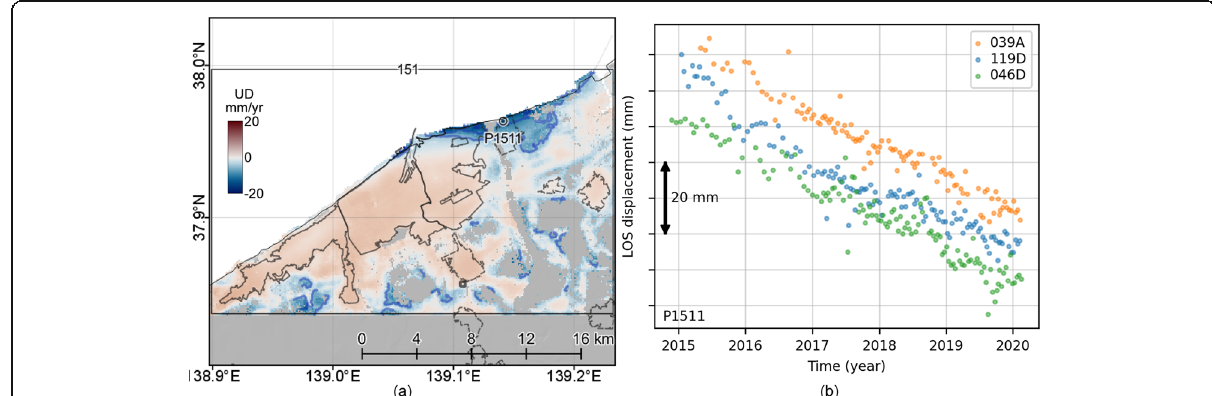
Fig. 4 a Vertical deformation velocities in Niigata (ID: 151). The black lines denote the outlines of the DID. The interval of the blue (subsidence) contour lines is 5 mm/year without the 0 mm/year lines. The black square denotes the reference point. ( b ) LOS deformation time series at P1511 for each